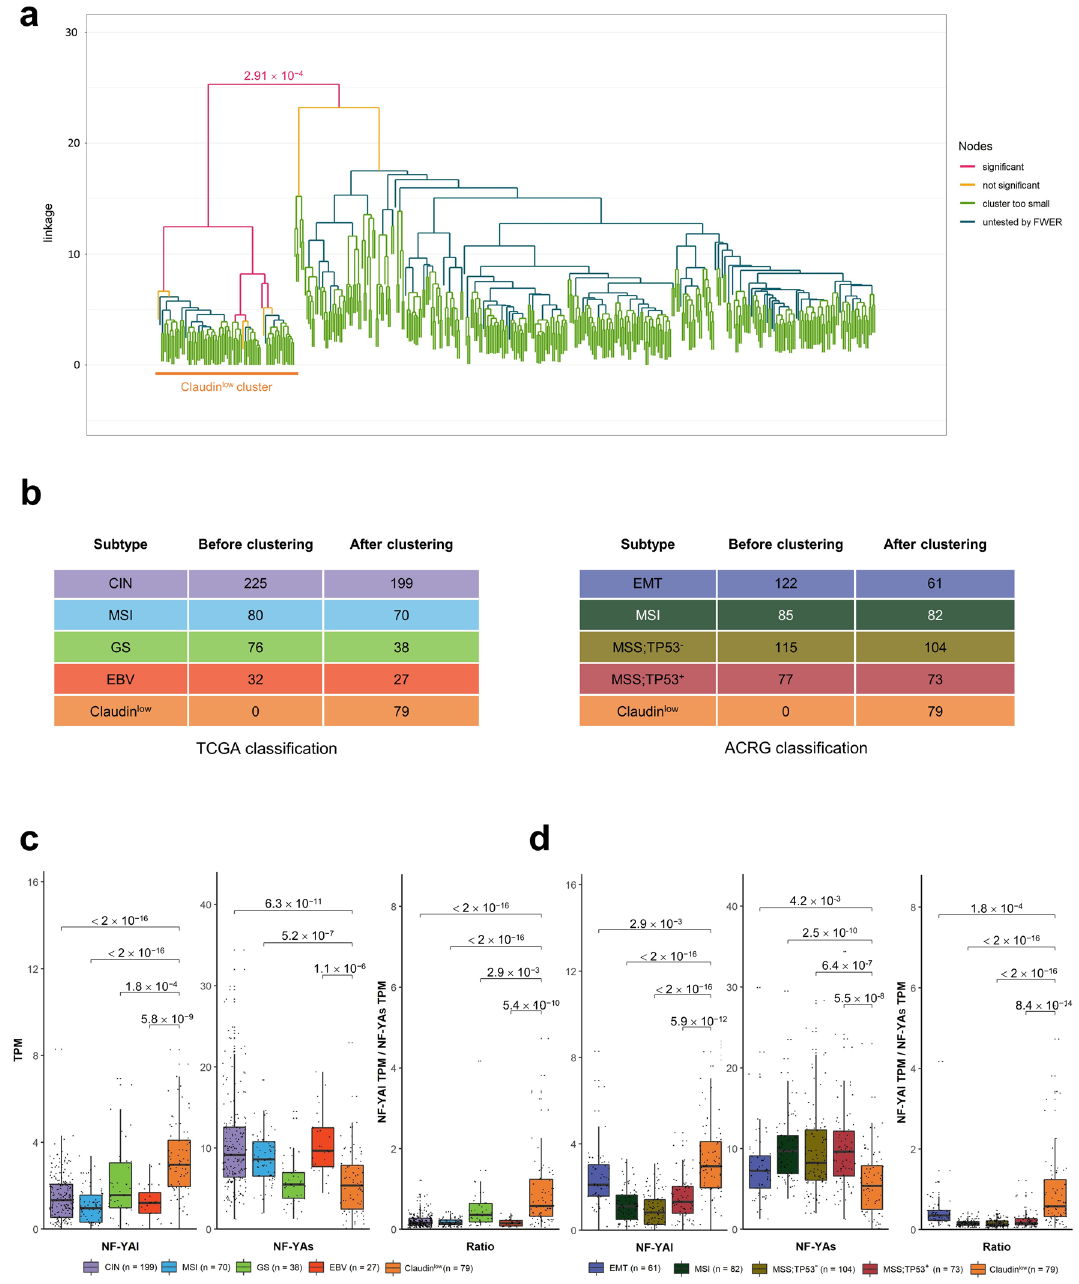
Figure 7. NF-YAl is predominant in Claudin low STAD tumors. ( a ) Hierarchical clustering of all TCGA tumor samples according to the 24 genes signature described in Ref. 37 . ( b ) Sample repartition in the TCGA (Left Panel) and ACRG (Right Panel) classifications, including the new Claudin low group identified in ( a ), before and after the clustering procedure. ( c ) Box plots of expression levels of NF-YAl (Left Panel), NF-YAs (Central Panel), and NF-YAl/NF-YAs ratio (Right Panel) in the TCGA classification, including the Claudin low group identified in ( a ). ( d ) Same as ( c ), except that the NF-YA isoforms expression levels are calculated for the ACRG classification subtypes. p values are calculated using the Wilcoxon rank-sum